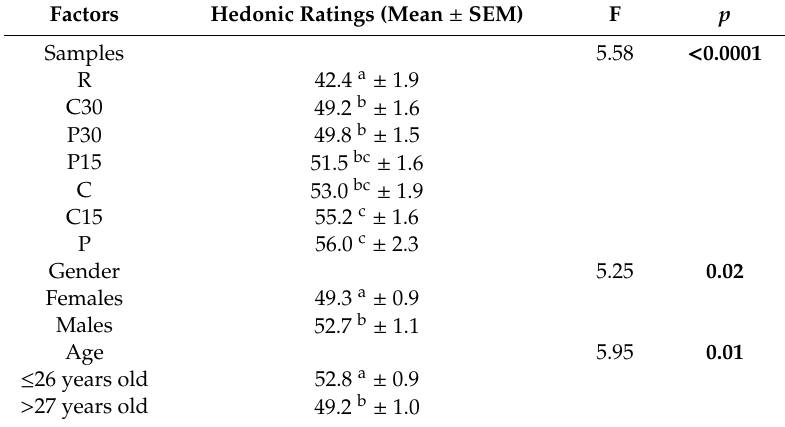
Table 2. Mean hedonic ratings ± SEM by samples, gender, and age groups. Hedonic scale range